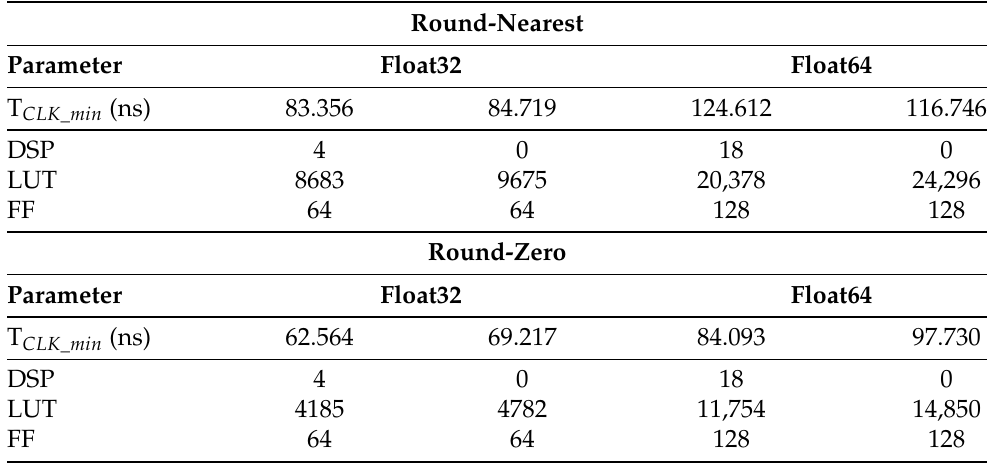
Table 5. Hardware needs in terms of speed (T CLK _ min ) and area (LUTs and FFs) with and wihtout DSPs, for different WLs and rounding modes when the floating-point NF is used in